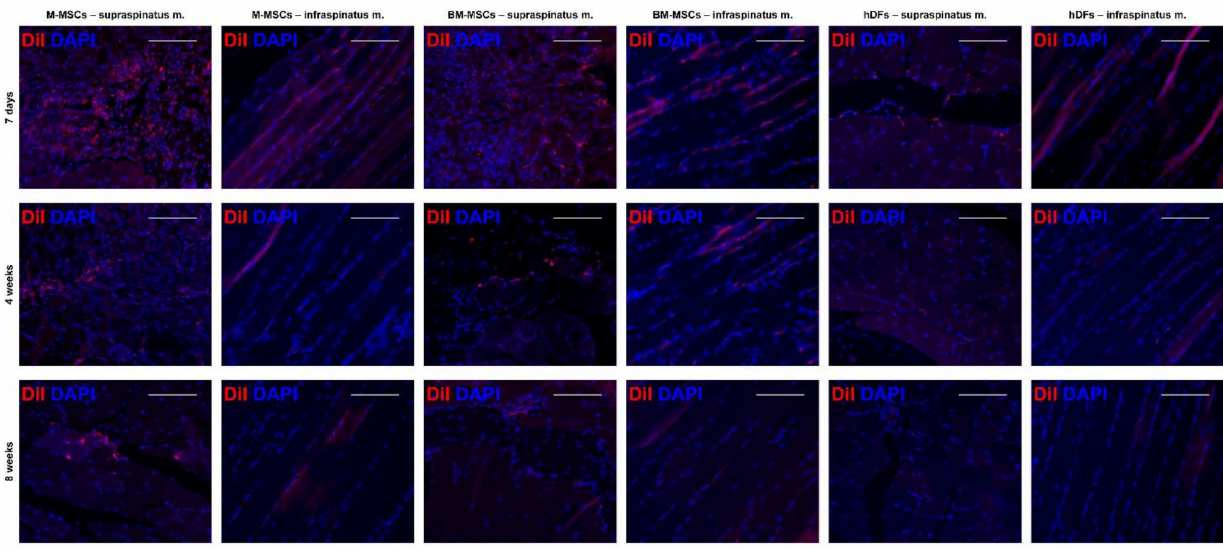
Figure 6. Long-term in vivo MSC tracking based on DiI. Supraspinatus and infraspinatus muscles were examined from hDF (control), BM-MSC and M-MSC groups at 7 days, 4 weeks, and 8 weeks after RCT induction. DiI+ cells were determined as red while all nuclei were shown DAPI blue. The scale bars are 100 µ